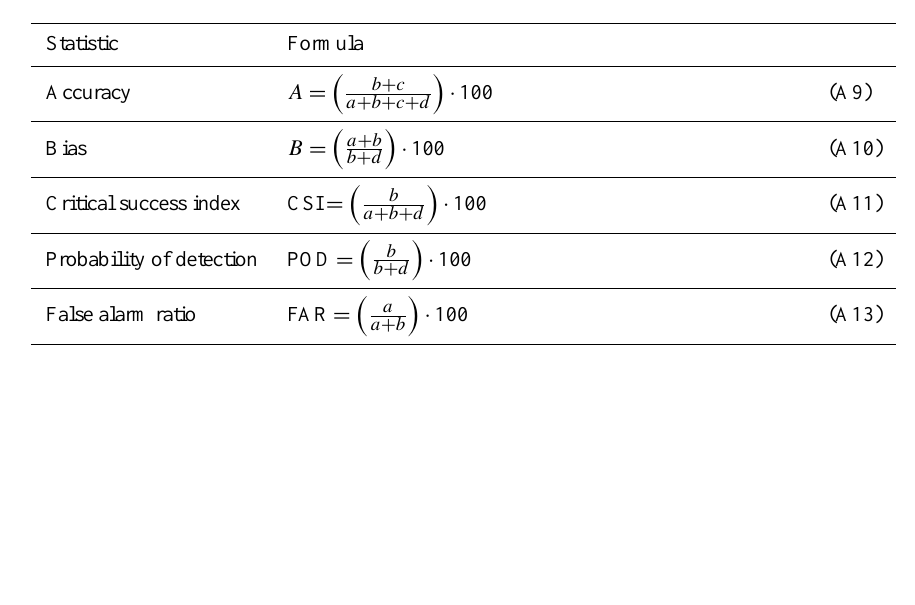
Table A2. Definition of the categorical statistics used in the evaluation. Exceedance analysis is based on a comparison with a fixed threshold concentration ( T ), where a is the number of false alarms, b is the number of hits, c is the number of correct negatives, and d is the number of